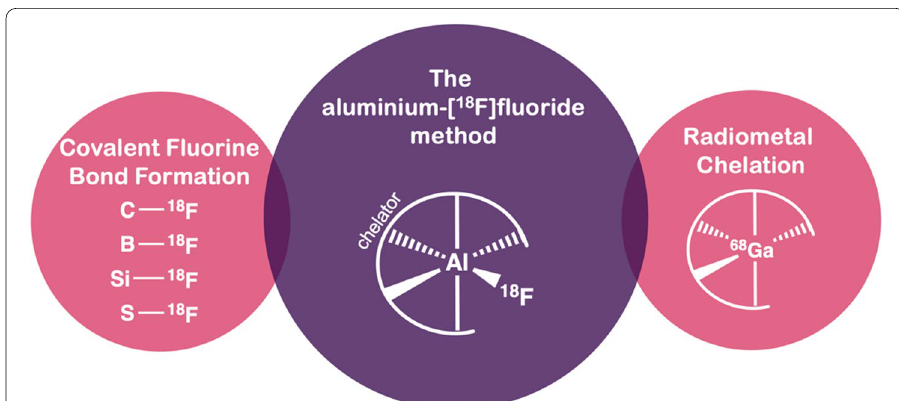
Fig. 1 A schematic of general PET radiolabelling methods